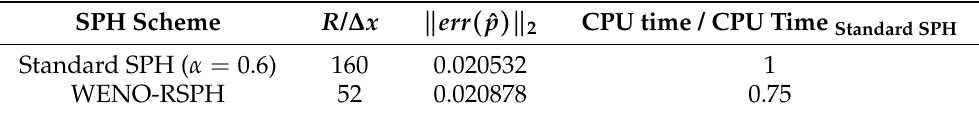
Table 2. Performance comparison of standard SPH and Riemann-based with WENO reconstruction SPH, for the 2D vortex case. Values of the L2 norm of the pressure error at ˆ t = 0.37 are provided. SPH Scheme Standard SPH ( α =